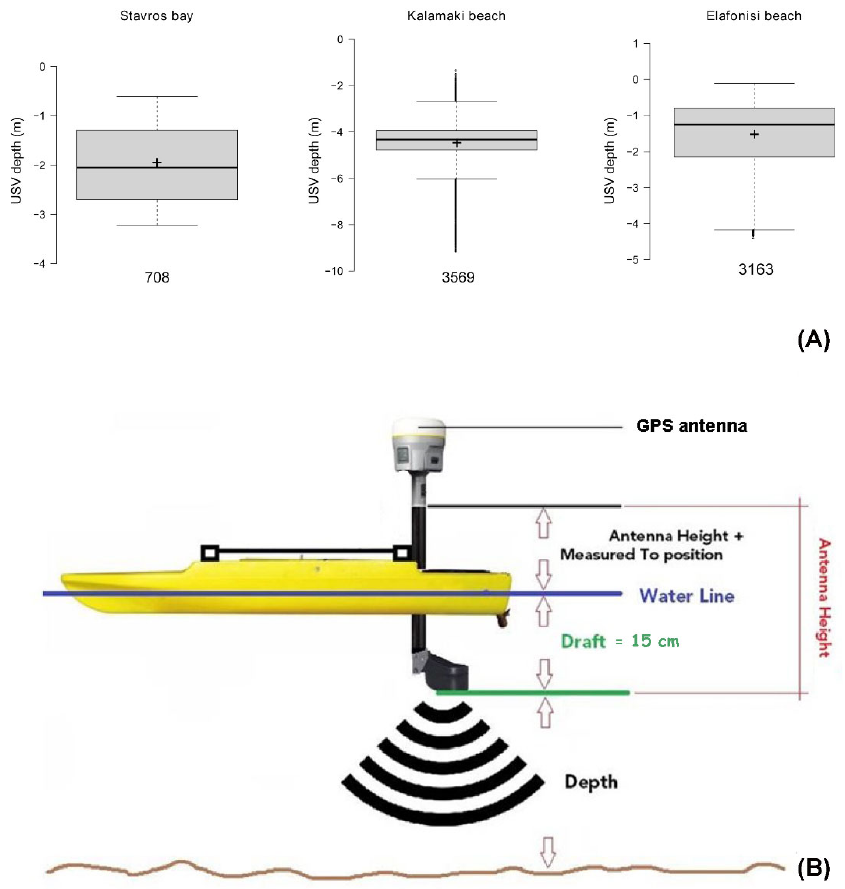
Figure 2. ( A ) Boxplots of the depth measurements collected by the USV at each study area. The number of samples is indicated at the bottom of each boxplot. Grey boxes correspond to 1st and 3rd quartiles, bold lines represent the median and crosses the mean value of the sample. ( B ) Configu- ration of the USV